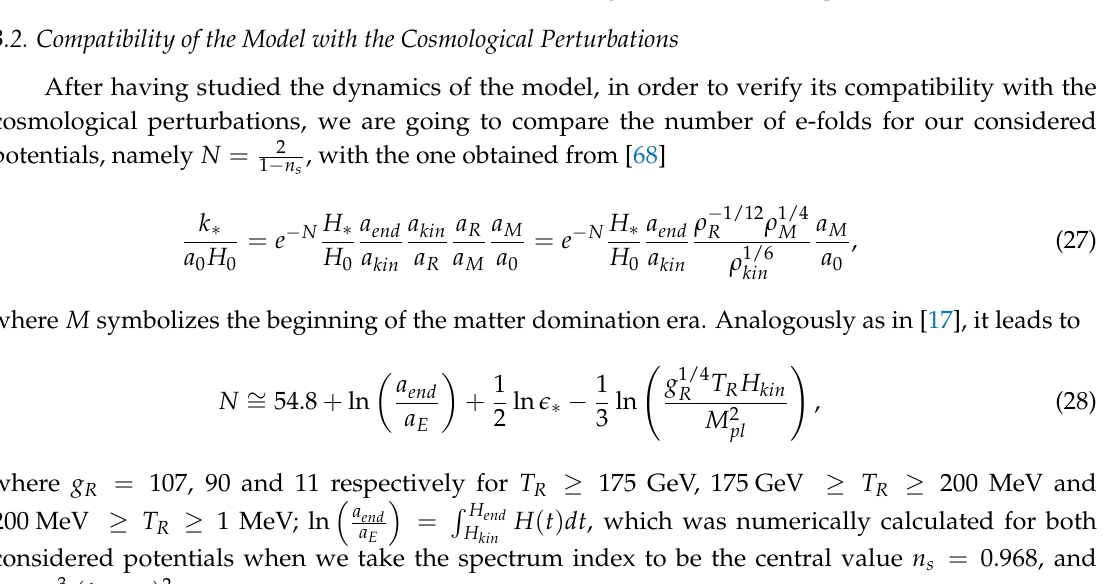
Figure 3. Numerical results for the allowed reheating mechanisms for the potential in